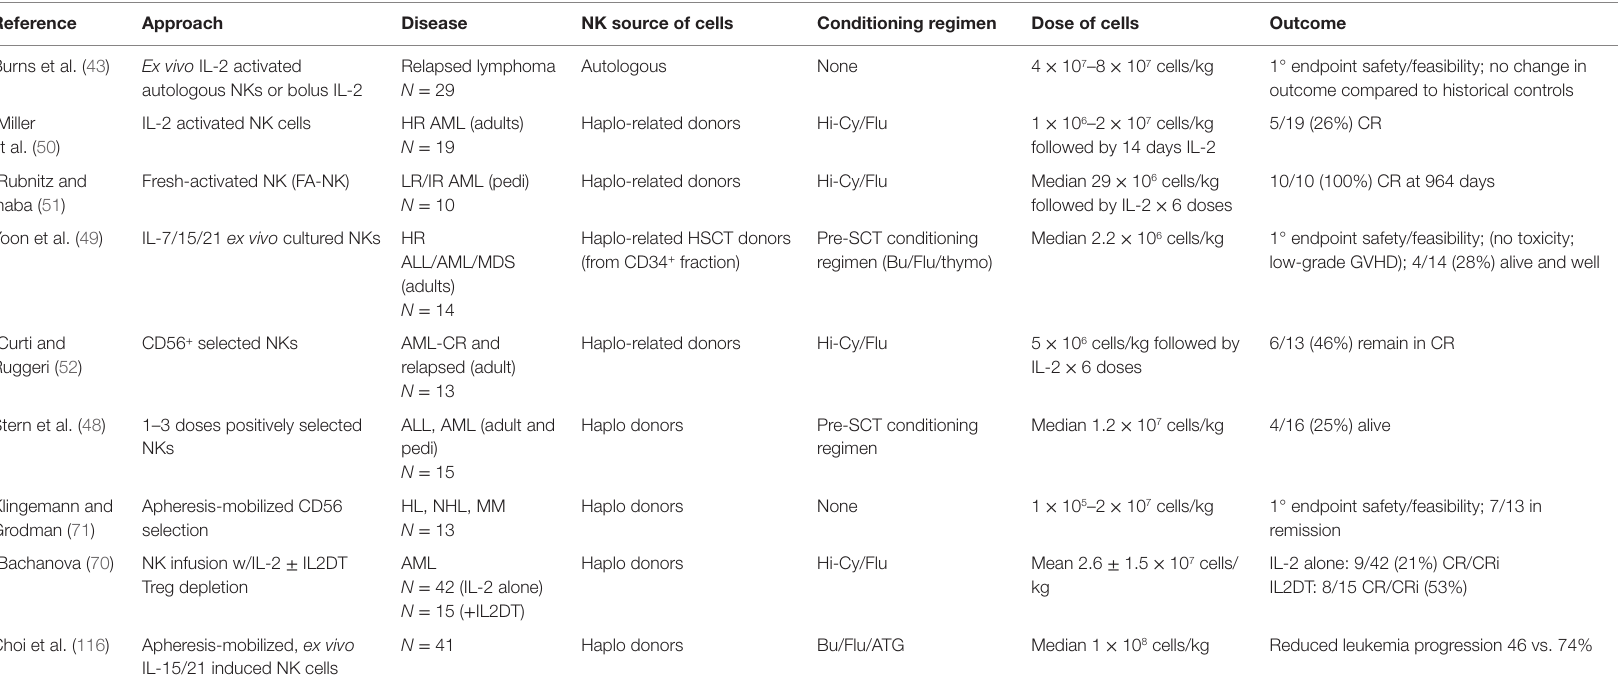
TABLe 1 | Published results of NK adoptive immunotherapy trials in hematologic